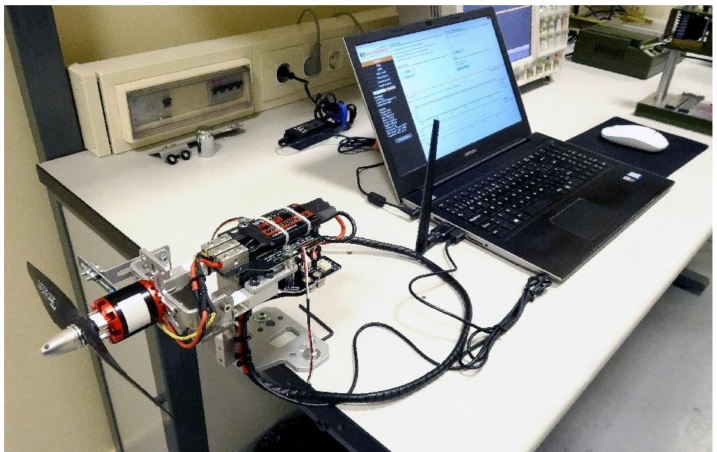
Figure 21. Computer controlled test bench for the study of BLDC motors.